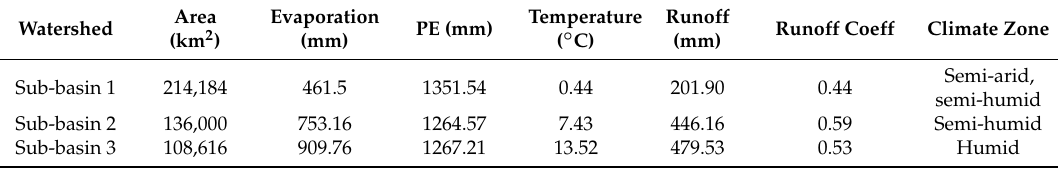
Table 1. The annual characteristics of three sub-basins of the Jinshajiang River basin